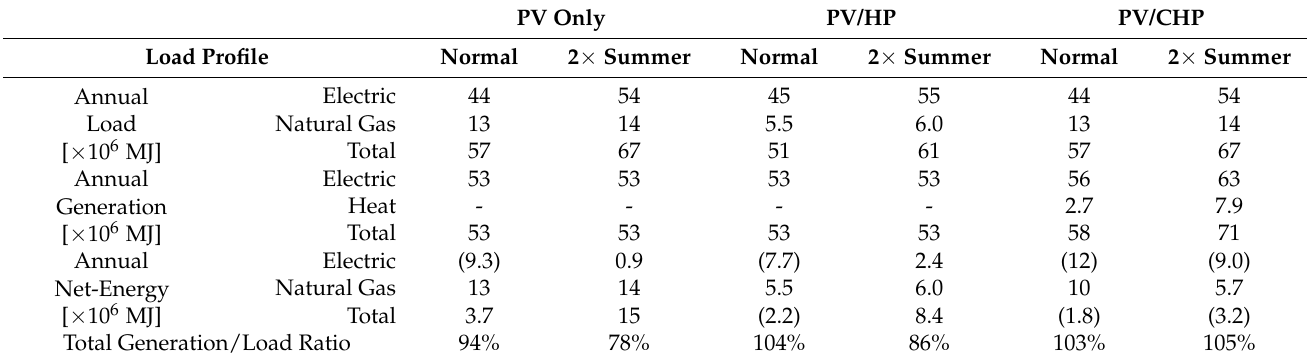
Table 2. NWC annual energy load and generation. Renewable energy scenarios incorporate PhotoVoltaic (PV), Heat Pump (HP), and Combined Heat and Power (CHP) technologies. Load and generation are listed as electric and natural gas (heat) in addition to total. Three of the six scenarios achieve net-zero energy status as indicated by the parenthesized negative annual net-energy and a total generation/load ratio greater than 100%. Net-zero energy is achieved through producing an excess of electricity to offset net natural gas